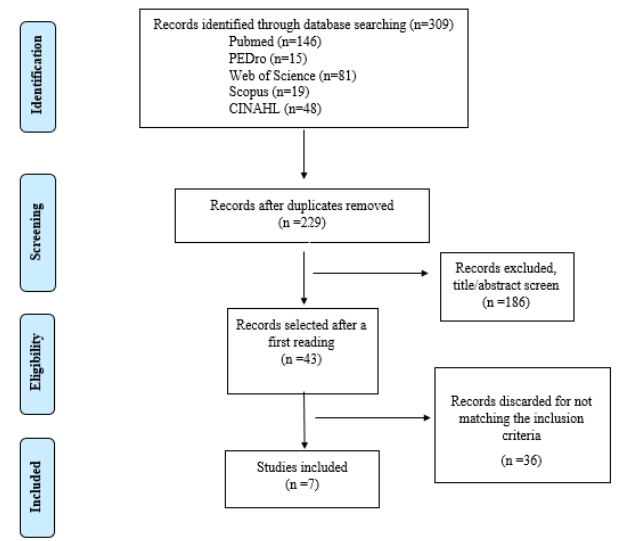
Figure 1. Flow Figure 1. Flow chart.